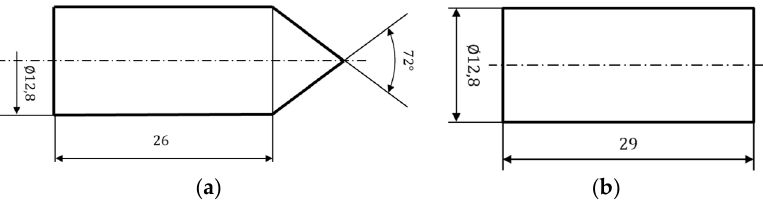
Figure 4. Dimensions of the projectiles for impact. ( a ) Conical projectile; ( b ) Blunt projectile. Dimensions in mm.